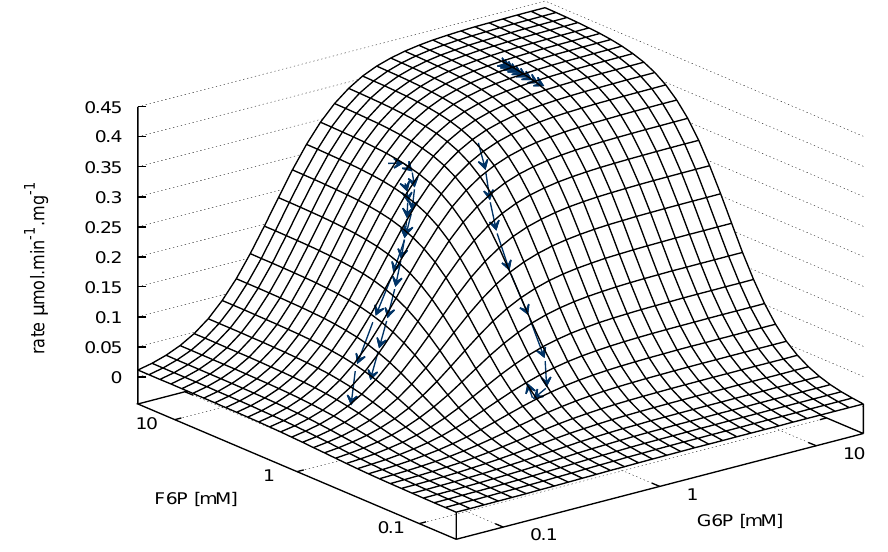
Figure 7. Phosphofructokinase: irreversible bi-substrate Hill equation globally-fitted to aggregated 31 P-NMR progress curves (see Table 1 for equation and fitted parameters). Rate is normalised to total protein. Substrate concentration axes are in logarithmic scale. Arrows indicate both the metabolite concentrations and the direction of the reaction for individual time courses ( →→→ ). PEP inhibitor assay data have been excluded from the plot as only two variables can be visualised simultaneously. R 2 = 0 .